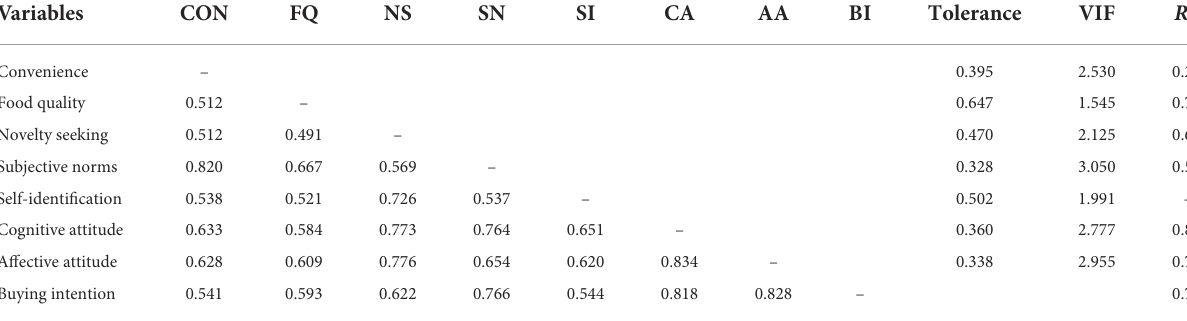
TABLE 3 Discriminant validity of first-order construct using Heterotrait-Monotrait Ratio (HTMT).